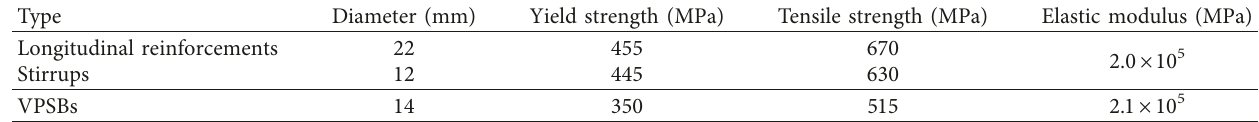
Table 1: Mechanical properties of steel rebars.